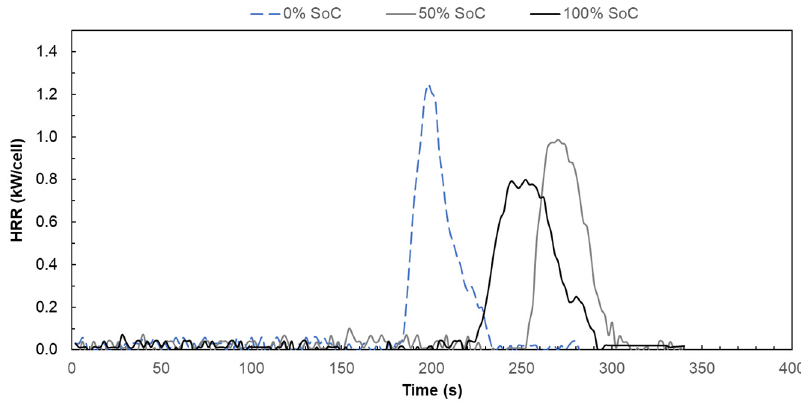
Figure 5. HRR for cells at 0% 50% and 100% SoC during tests at 50 kWm − 2 .